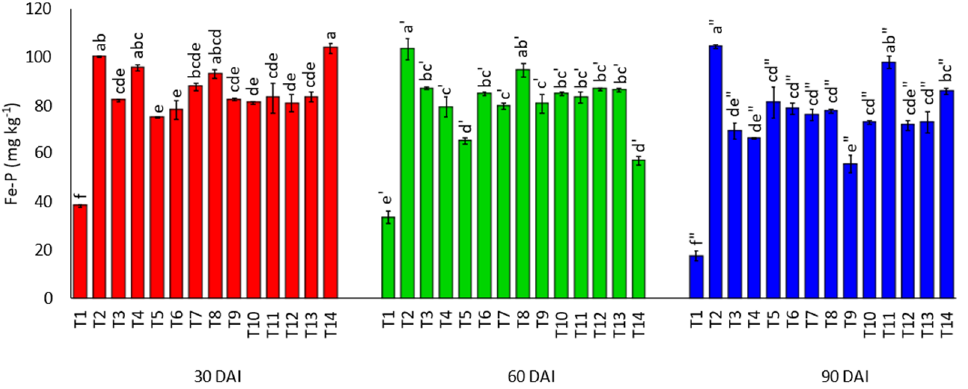
Agronomy 2021 , 11 , x 18 of 28 Figure 18. Effects of treatments on iron-bound phosphorus after thirty, sixty, and ninety days of incubation, where T1: soil alone, T2: Egypt rock phosphate alone, T3: Egypt rock phosphate + 100% charcoal, T4: Egypt rock phosphate + 100% sago bark ash, and T5: Egypt rock phosphate + 100% charcoal + 100% sago bark ash, T6: Egypt rock phosphate + 75% charcoal + 75% sago bark ash, T7: Egypt rock phosphate + 50% charcoal + 75% sago bark ash, T8: Egypt rock phosphate + 25% charcoal + 75% sago bark ash, T9: Egypt rock phosphate + 75% charcoal + 50% sago bark ash, T10: Egypt rock phosphate + 50% charcoal + 50% sago bark ash, T11: Egypt rock phosphate + 25% charcoal + 50% sago bark ash, T12: Egypt rock phosphate + 75% charcoal + 25% sago bark ash, T13: Egypt rock phosphate + 50% charcoal + 25% sago bark ash, and T14: Egypt rock phosphate + 25% charcoal + 25% sago bark ash. Means with different letter(s) within the same incubation period indicate significant differences between treatments according to Tukey’s HSD test at p ≤ 0.05, i.e., a > b > c. Bars represent the mean values ± SE.